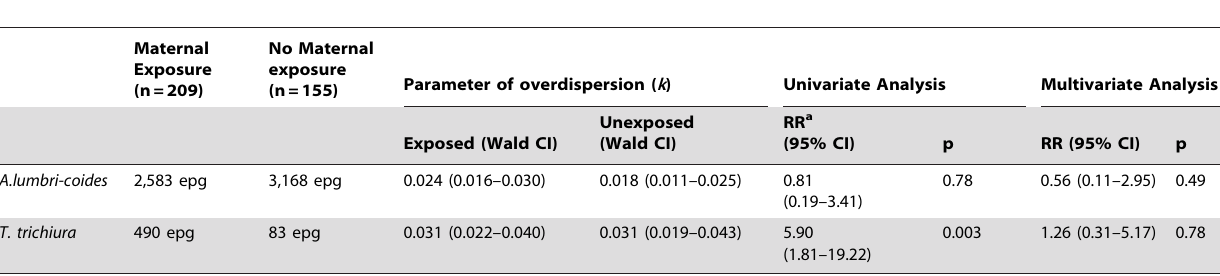
Table 3. Effects of maternal infection on childhood infection intensities and overdispersion.